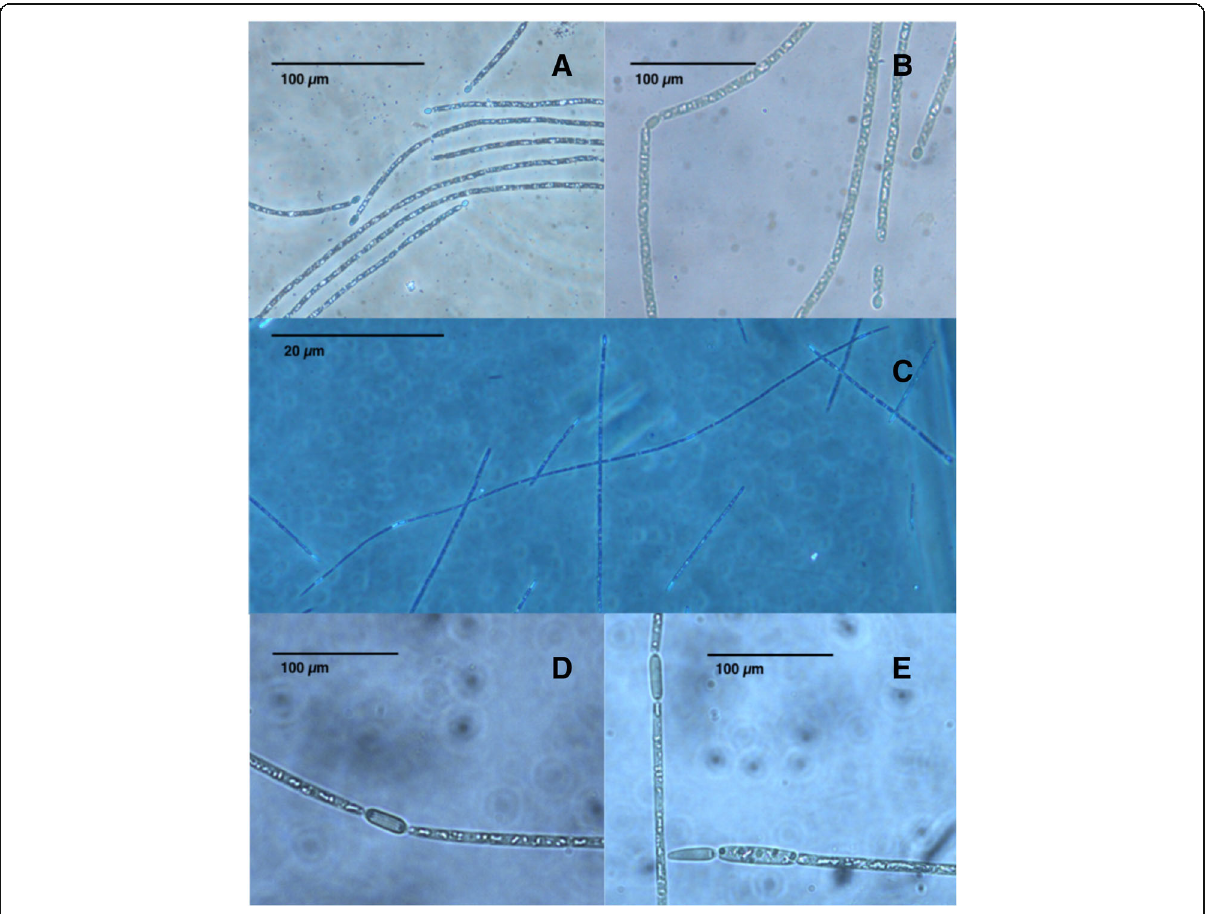
Fig. 1 Light microscope photographs of source organisms. a - b C. raciborskii CS-508 and of c - e C. raciborskii